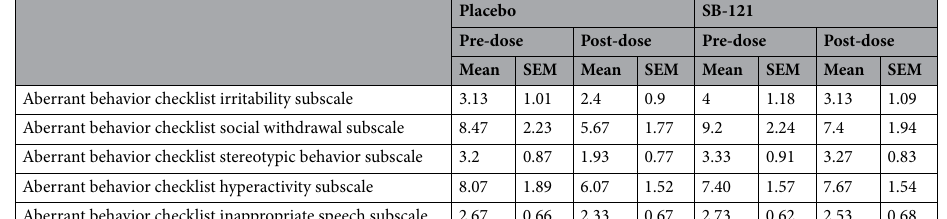
Placebo SB-121 Pre-dose Post-dose Pre-dose Post-dose Mean SEM Mean SEM Mean SEM Mean